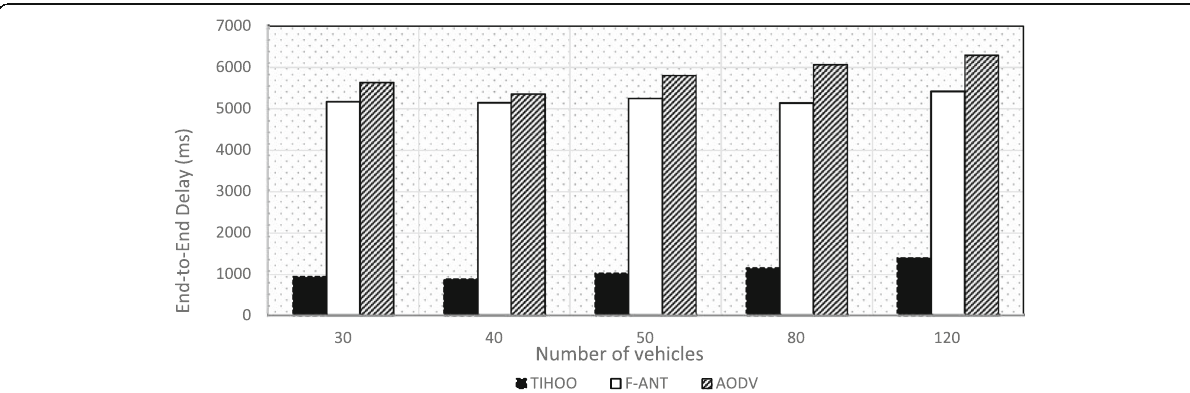
Fig. 7 End-to-end delay based on the number of vehicles. When the number of vehicles increases, end-to-end delay also increases. Applying the cuckoo metaheuristic algorithm to TIHOO has helped in the selection of the best route in a shorter time than the other two protocols. In contrast to F-ANT which is very slow to converge as a result of the ant colony optimization algorithm (ACO), TIHOO has a fast convergence rate and could identify the optimal route in a shorter time. Moreover, the intelligent configuration of the fitness function of this protocol and considering parameters such as available buffer have proved to be very useful in the deselection of congested routes. The selection of less busy routes has